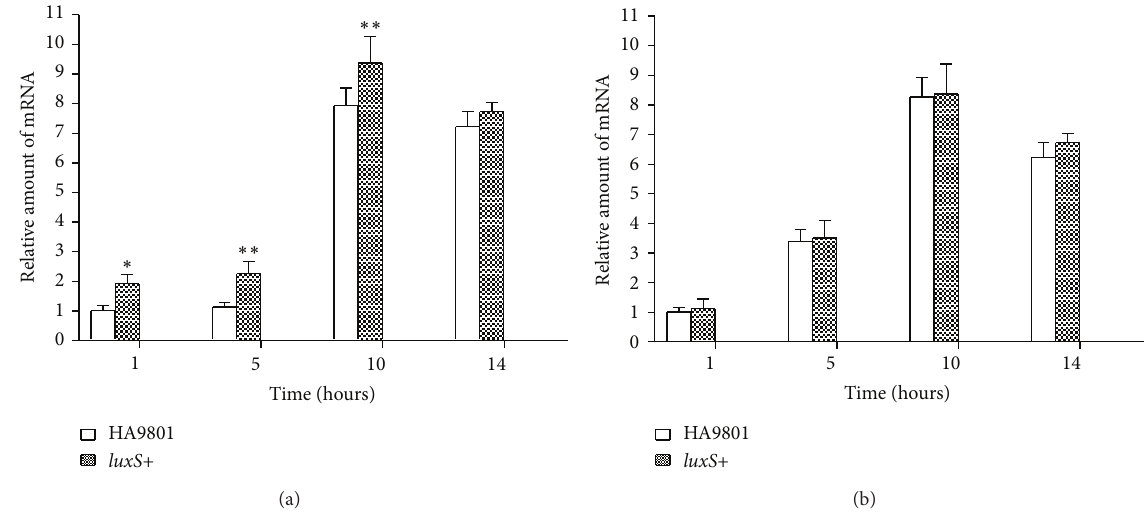
Figure 1: Analysis of the profile of luxS and pfs transcription in the different time. The expression level of luxS (a) and pfs (b) mRNA were analyzed using real-time PCR. Using 16S rRNA gene as reference gene, the expression level of 1h is considered as 100%; relative expression is count as CT ( 2 −ΔΔ CT ). Values are the means of results of three independent experiments. Error bars indicate standard deviations ( 𝑃 < 0.05